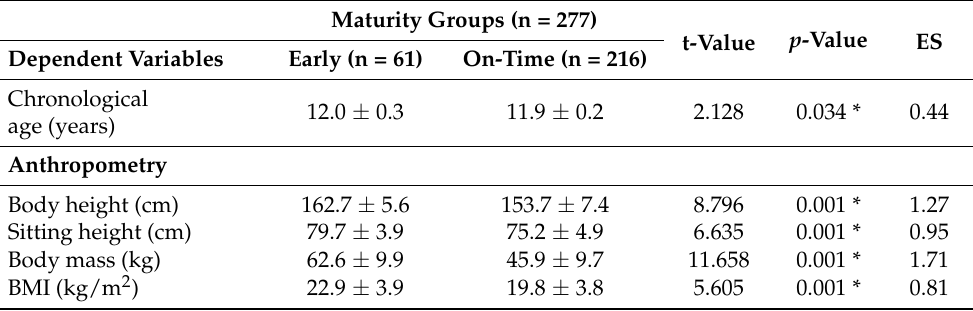
Table 5. Descriptive statistics of girls by maturity status and the results of t-test, comparisons, and effect size